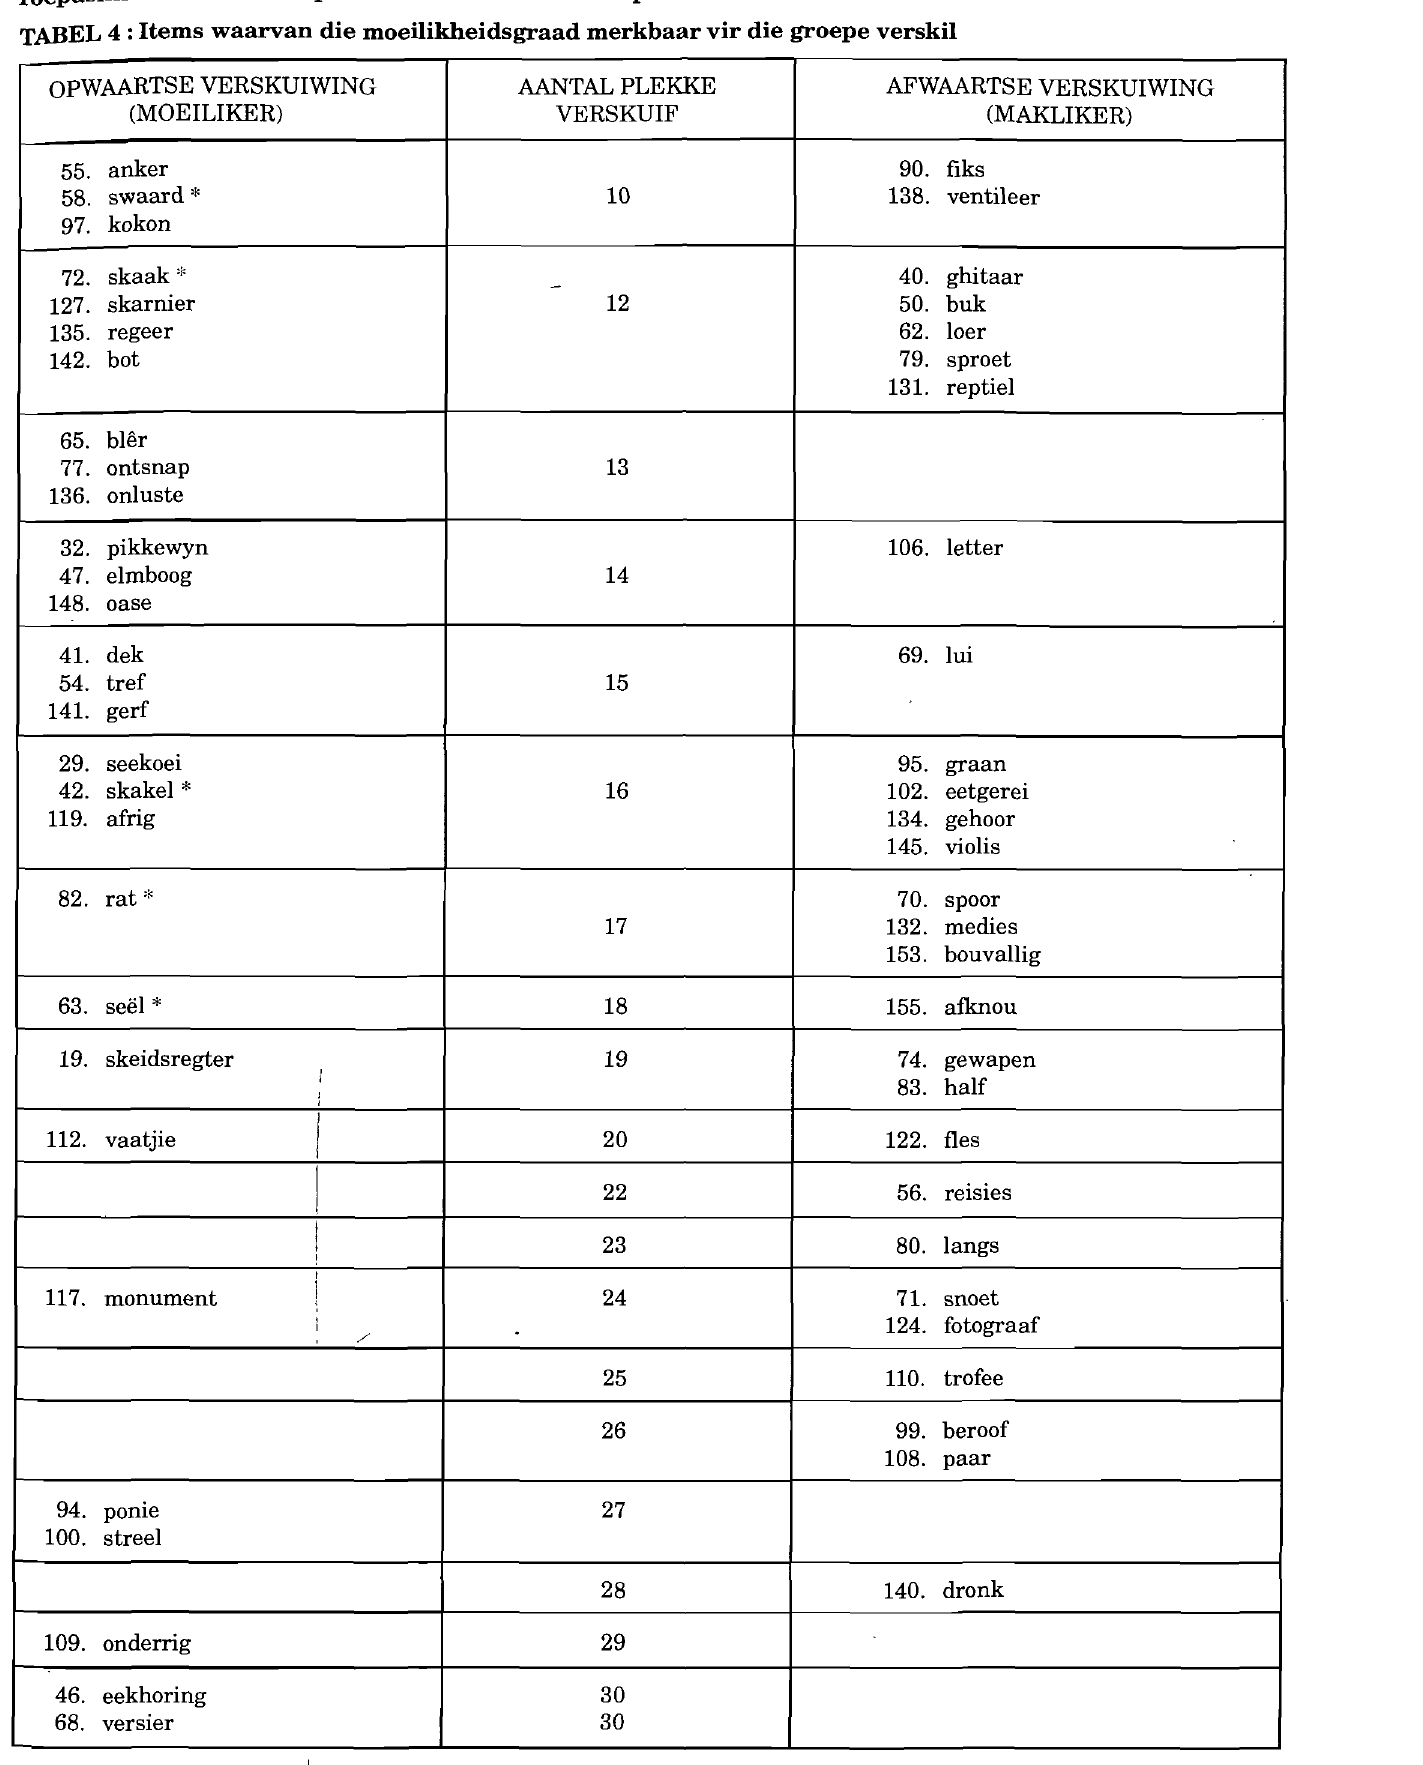
TABEL 4 : Items waarvan die moeilikheidsgraad merkbaar vir die groepe